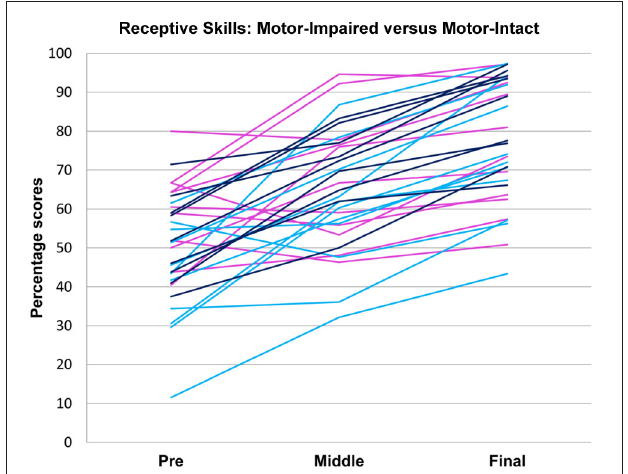
FIGURE 3 | Receptive language scores over time in motor-impaired (magenta) and motor-intact (blue) groups. The motor-impaired group improved less than the motor-intact group; note the group difference in line slopes. (For consistency with the other figures, the motor-intact group is color-coded separately as light blue for the receptive-impaired subgroup and dark blue for the